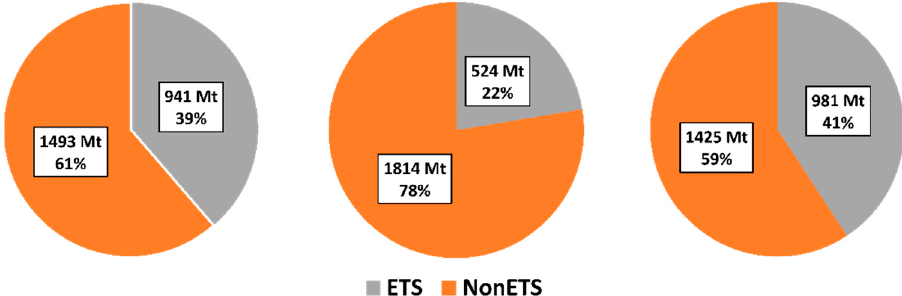
Figure 3. Emission budget for the ETS and Non-ETS in 2030 (Optimal, ETS first, ESR more).